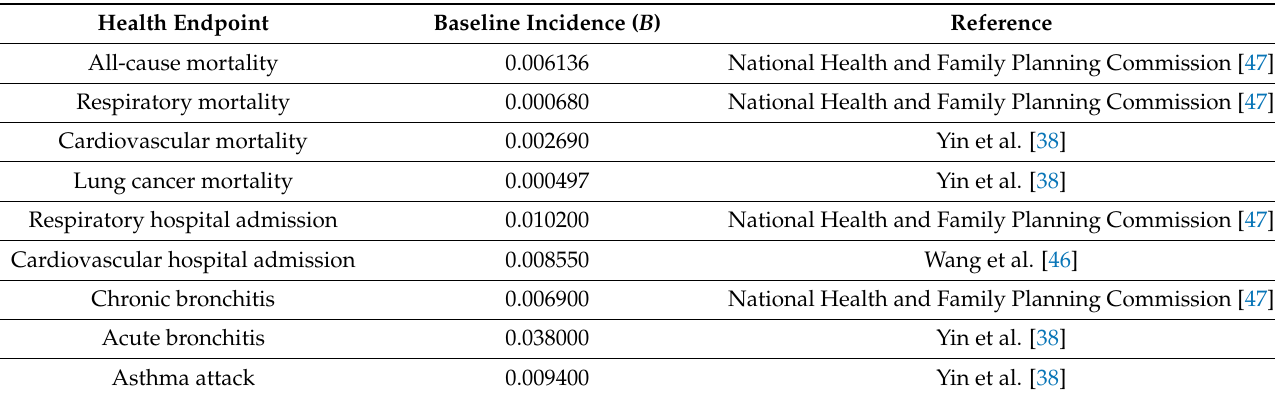
Table 2. Baseline incidence of each health